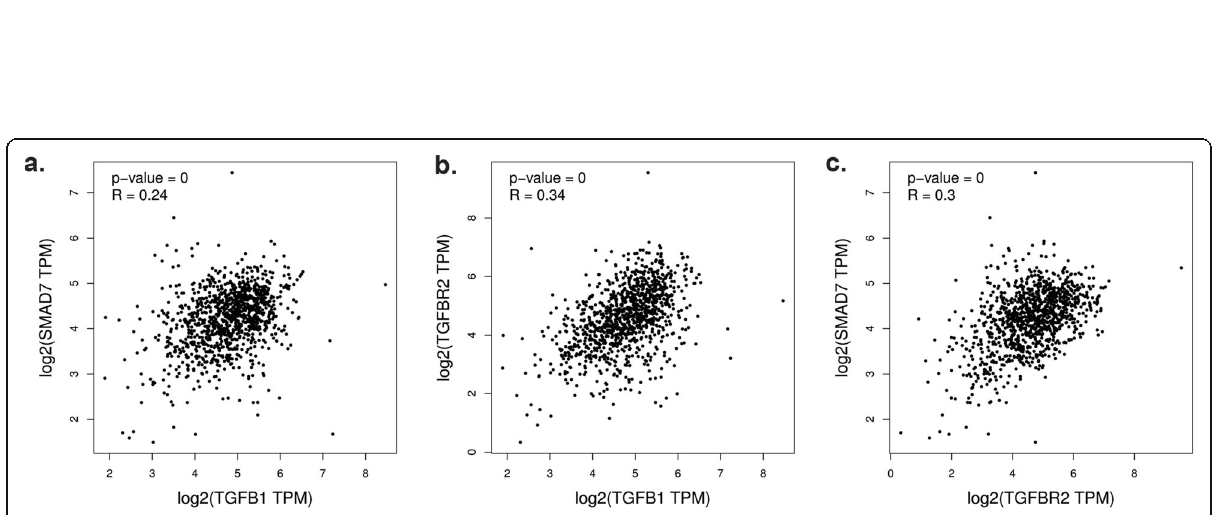
Fig. 4 Correlation between TGFB1 , TGFBR2 and SMAD7 genes in breast cancer samples from TCGA project. Extremely significant correlations were evidenced between the expression of TGFB1 and TGFBR2 ( a ), TGFB1 and SMAD7 ( b ) and between TGFBR2 and SMAD7 ( c ) genes in tumor tissue samples from the breast cancer cohort of TCGA project. SMAD7 was evaluated as a reporter gene for the activation of classical TGF β pathway in these analyses. Graphs and statistics generated using the GEPIA2 analysis resource